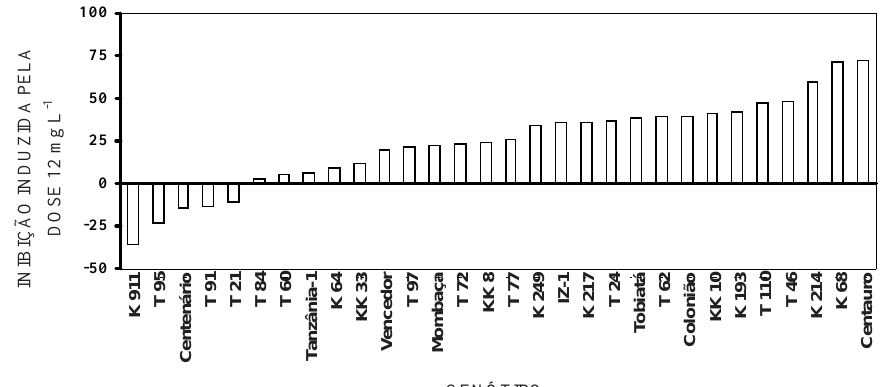
Figura 2. Inibição do alongamento radicular de 30 genótipos de Panicum maximum induzida por 12 mg L -1 de Al em solução nutritiva.